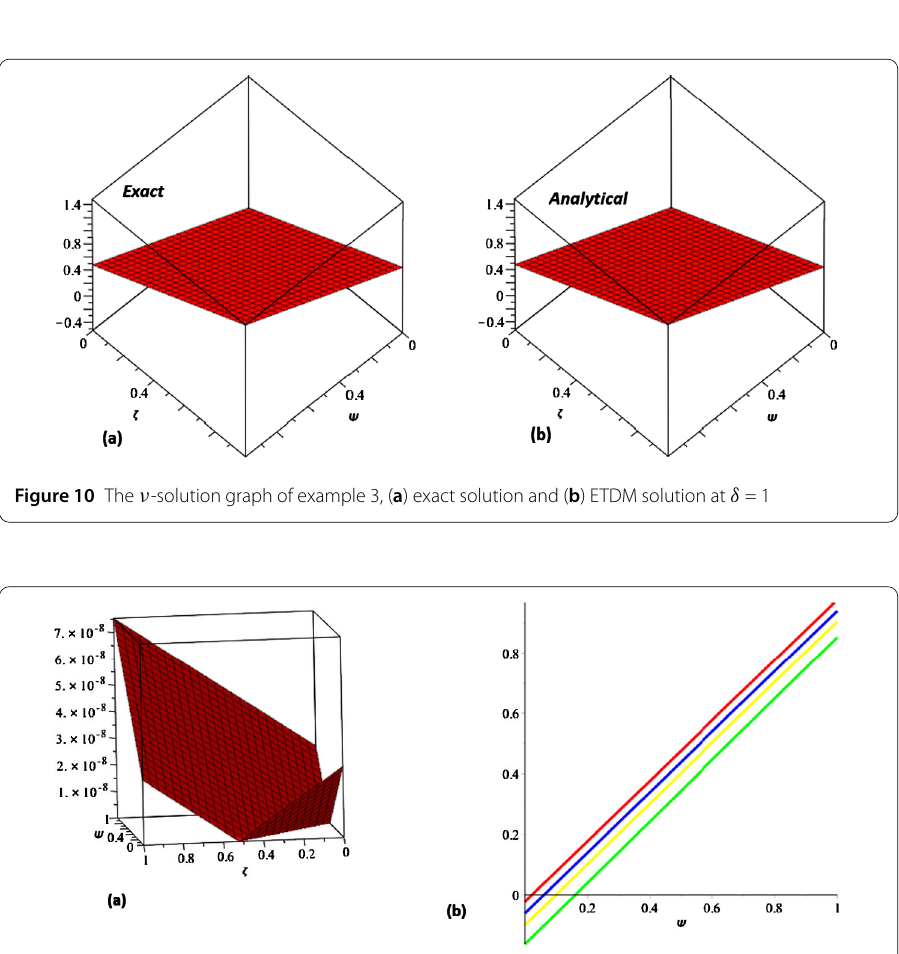
shown the sufficient degree of accuracy. Tables 3 and 4 provide the comparison of exact and ETDM solutions in term of absolute error at δ = 1, at time τ = 0.0005 for variable μ and ν